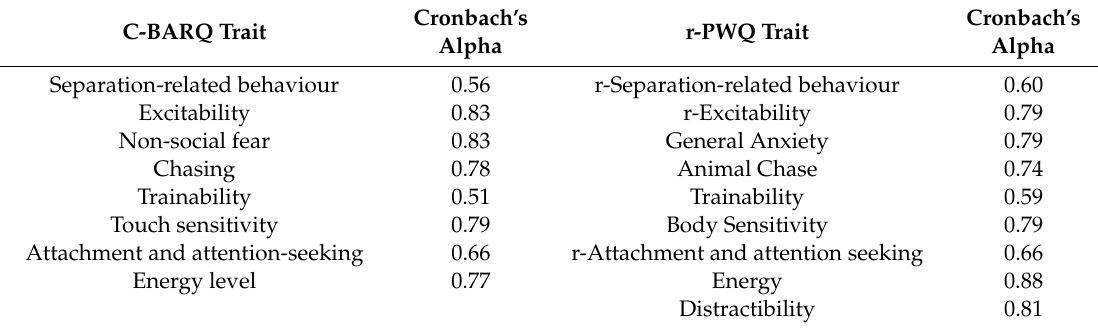
Table 3. Cronbach’s alpha values for C-BARQ and r-PWQ traits.